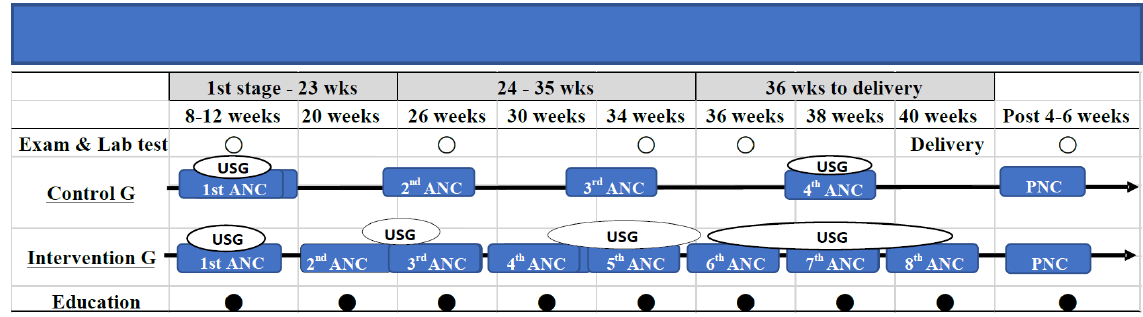
Figure 2. Activities compared Control and Intervention group.